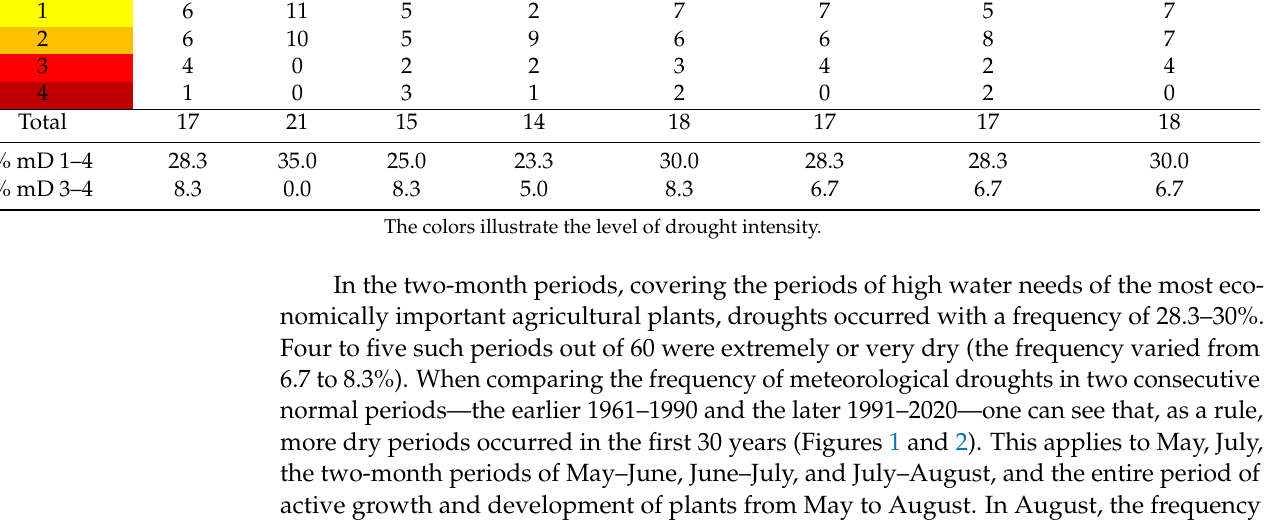
Table 2. The number and frequency of meteorological droughts (mD) during the period of active plant growth in the region of Bydgoszcz in 1961–2020. Class of